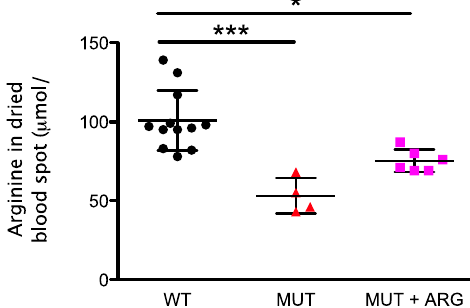
Figure 4. Monitoring of arginine levels in dried blood spot. Samples were collected from wild type (WT, n = 12), argininosuccinate lyase deficient littermates untreated (MUT, n = 4), or treated with daily intraperitoneal injections of L ‐ arginine (1 g/kg/d) (MUT + ARG, n = 6). Samples were collected at 3–8 weeks of life. Graphs represent mean ± SD.